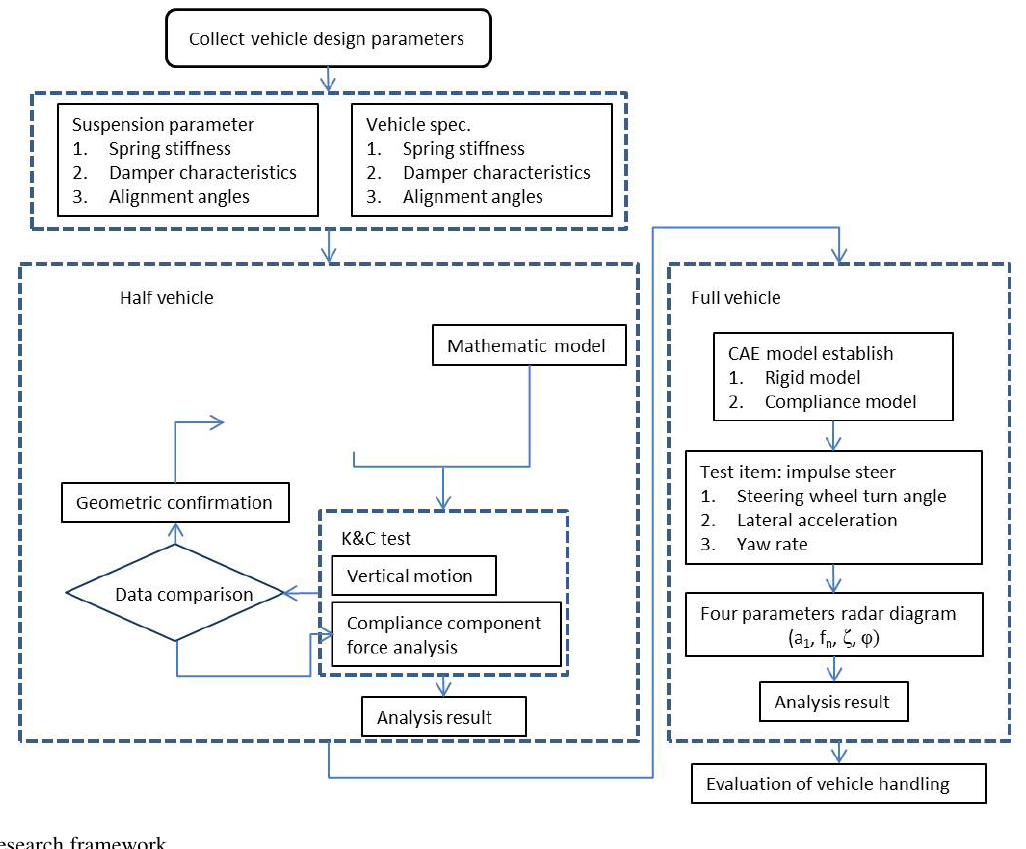
Figure 2. Research